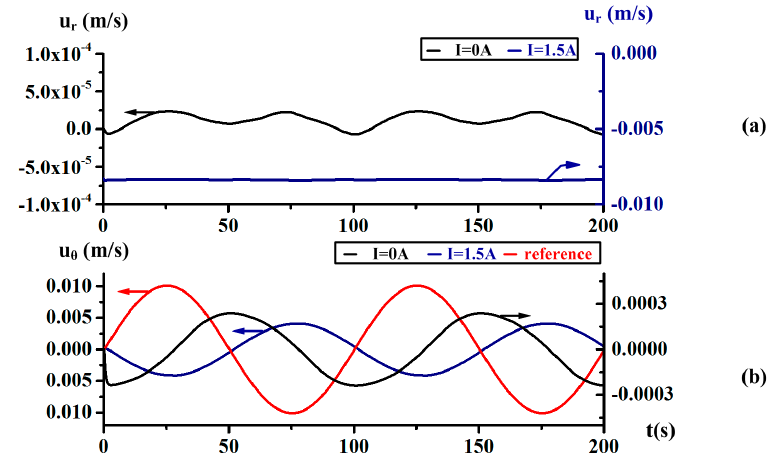
Figure 9. The radial velocity u r and relative circumferential velocity u θ of test point P (0.010, 0, − 0.001)